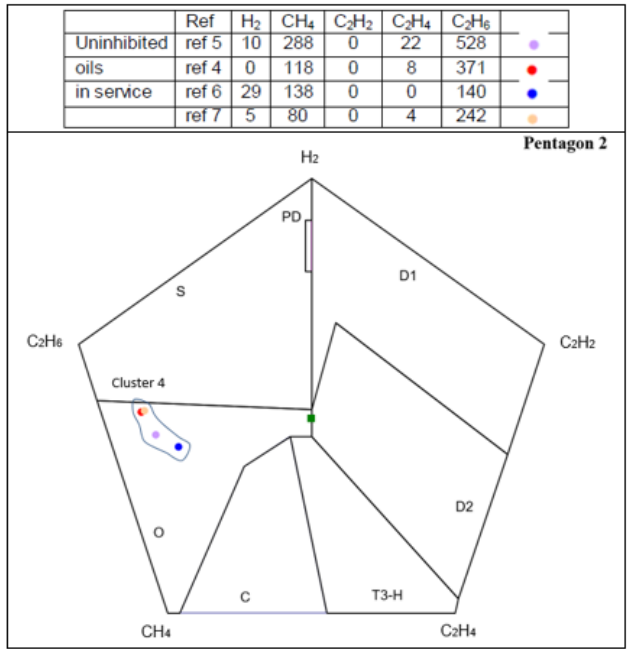
Figure 10. SG of uninhibited mineral oils other than oil B in transformers other than those from the FKH, in Cluster 4.